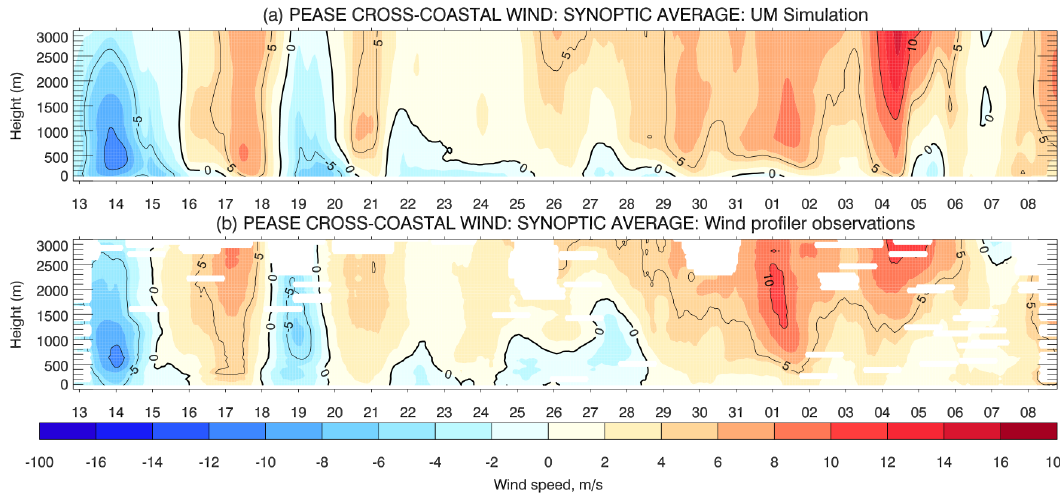
Figure 2. 24h centred running average of cross-coastal direction wind speed at Pease (a) as simulated by the MetUM and (b) as observed by 915MHz wind profiler. The x axis is labelled with the dates in July and August 2004. Positive wind speeds represent offshore flow and negative wind speeds represent onshore